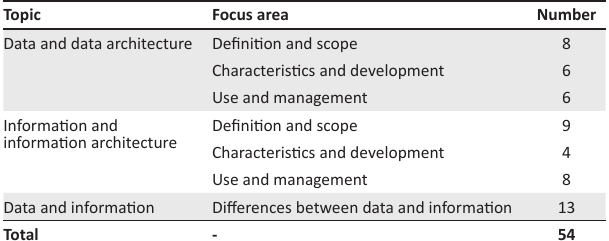
TABLE 1: Data collection.